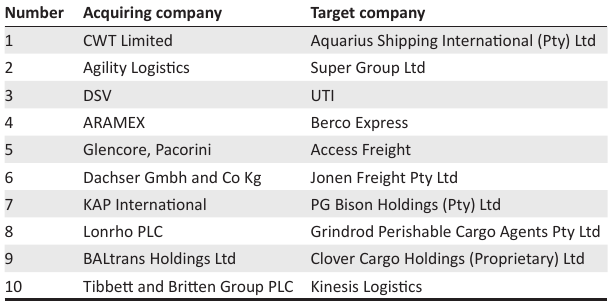
TABLE 2: Top 10 identified (acquiring and target) companies.